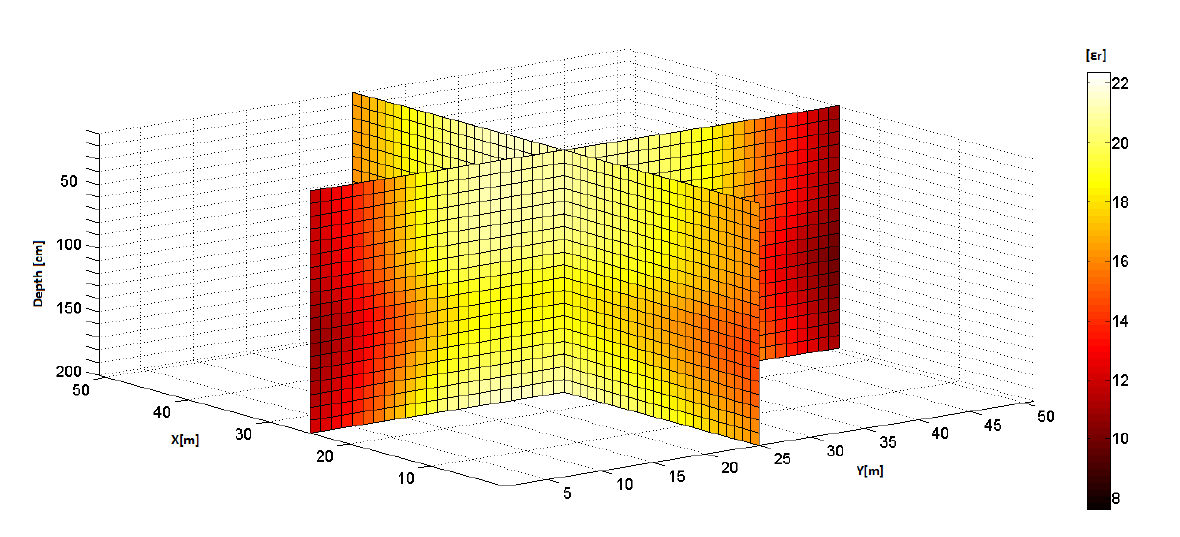
Figure 7. Relative permittivity section in clay soil textures.